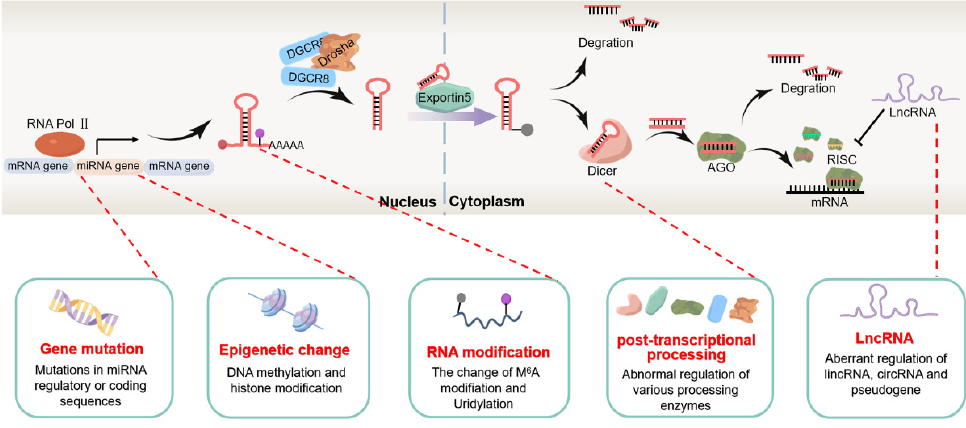
Figure 1. Summary of miRNA expression regulation mechanism in tumors. The expression of miRNAs in tumors is complexly regulated by miRNA genome mutations, epigenetic changes, RNA modifications, abnormal splicing by processing enzymes, and lncRNAs.